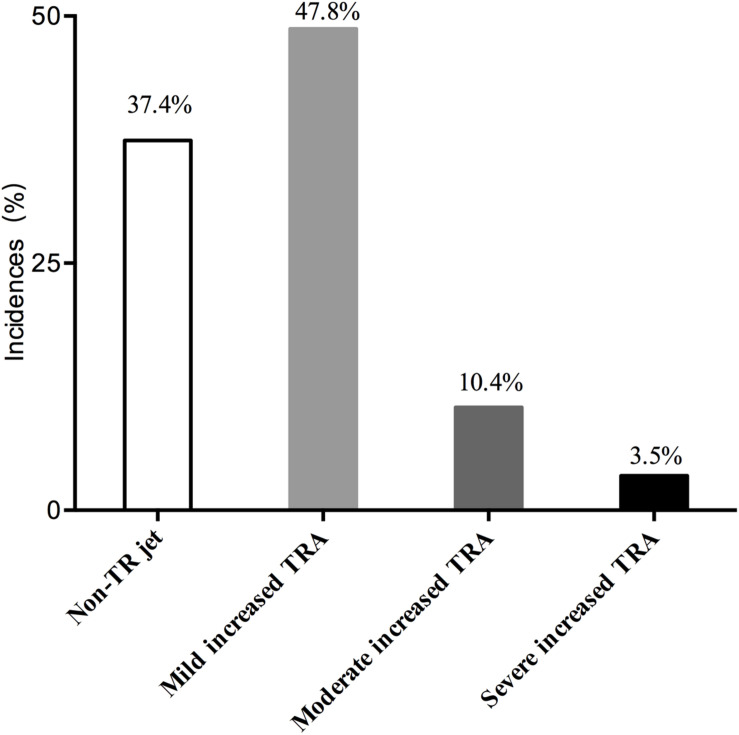
Distributions of TRA in the ESRD patients.